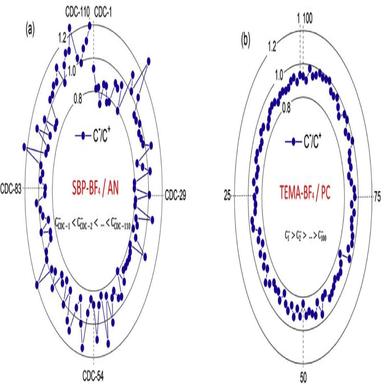
Radial diagrams of relative ratios of cathodic and anodic capacitances (C/Cþ) for 110 carbon samples in SBPeBF4/AN electrolyte of this study (a) and for 100 samples in TEMA-BF4/PC electrolyte of ref. (b). Cathodic capacitance (C) increases clockwise from CDC-1 to CDC-110 (a) and from 100 to 1 (b), respectively. (A colour version of this figure can be viewed online.)